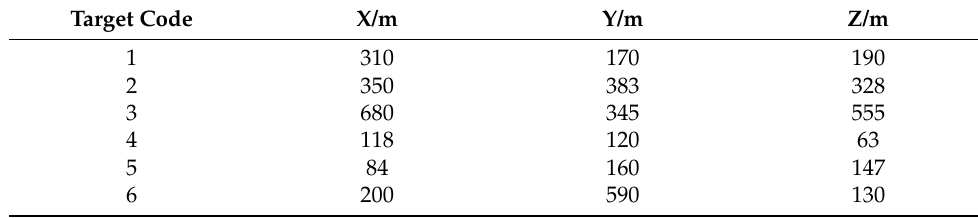
Table 6. Target coordinates.